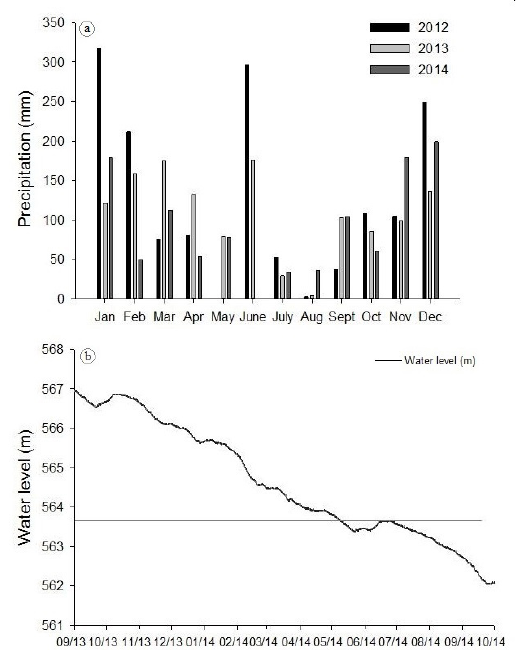
Figure 2. Monthly rainfall variation (mm) for three years (a) and water level from September 2013 to October 2014 (b) and threshold of connection between the Paranapanema River and the lateral area.